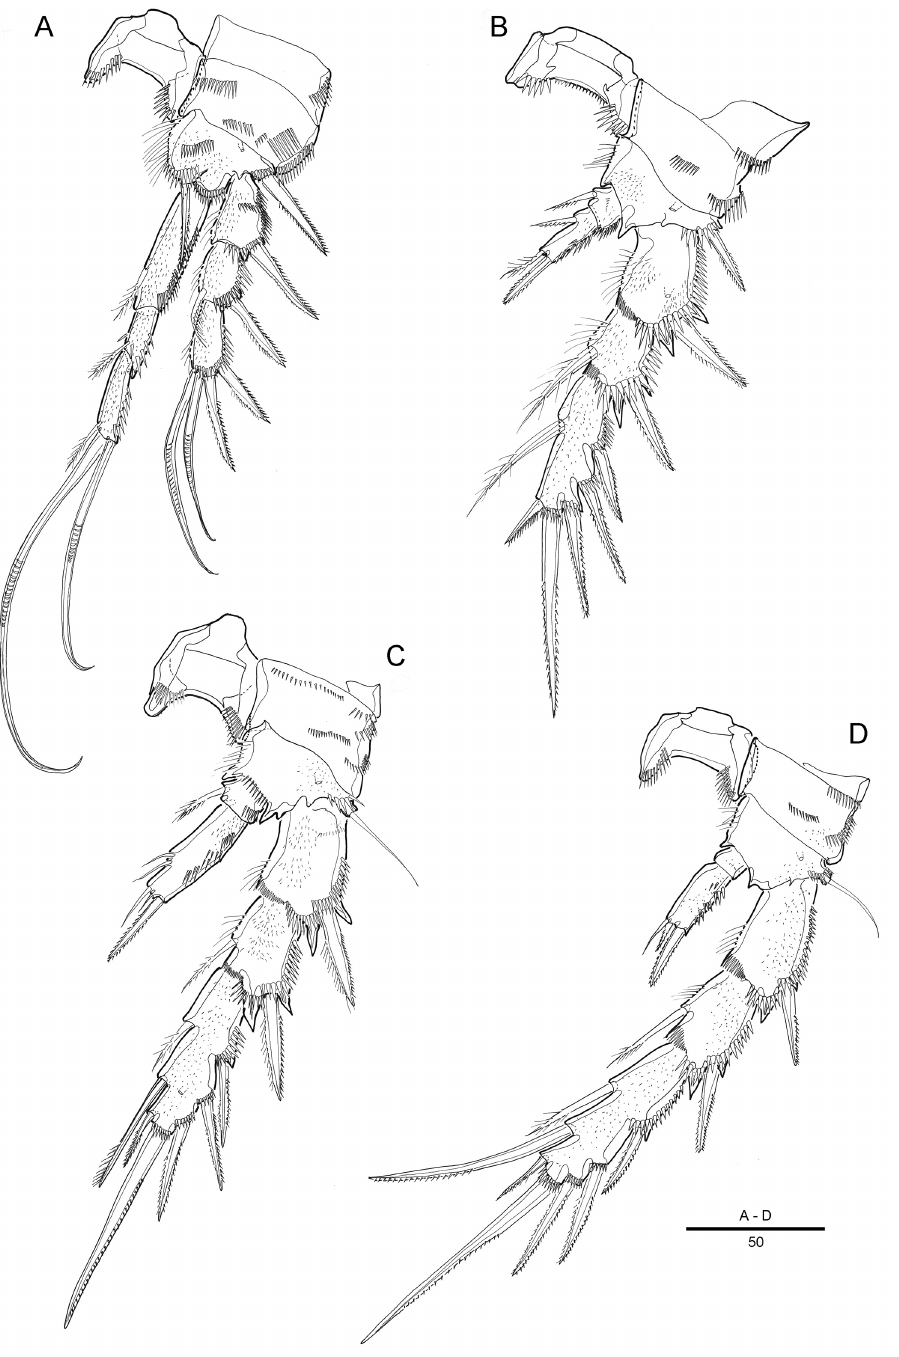
Figure 3. Attheyella ( Attheyella ) tahoensis sp. n. female: A P1, anterior B P2, anterior C P3, anterior D P4,